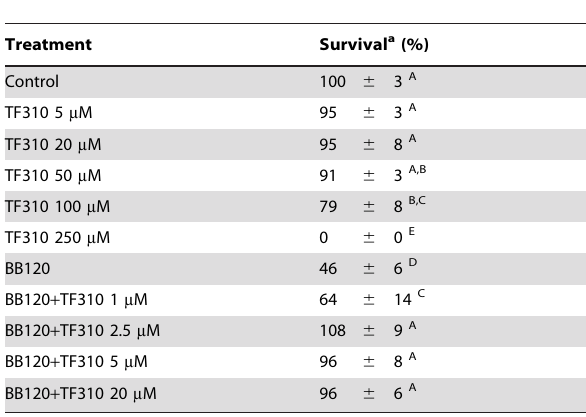
Table 1. Relative percentage survival a of brine shrimp larvae with and without TF310 (average 6 standard deviation of three replicates), after 2 days, with and without the pathogen V. harveyi